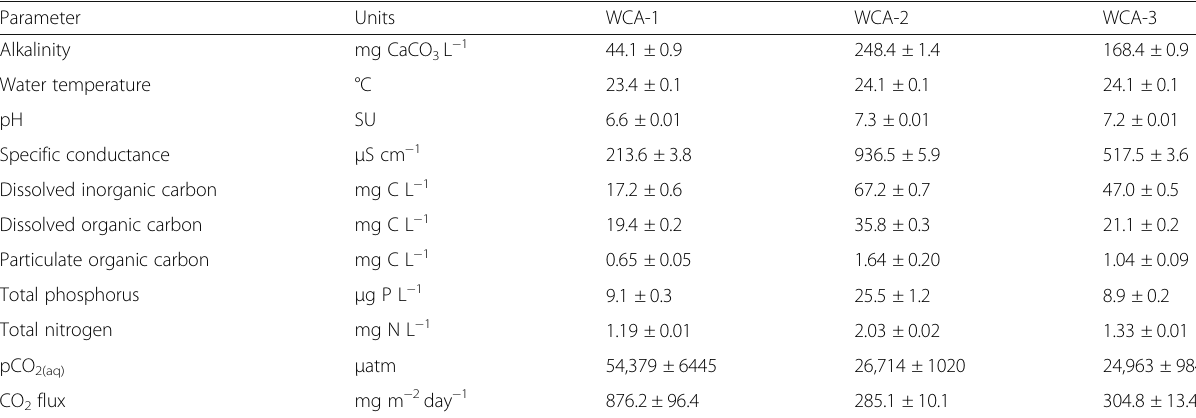
Table 3 Mean ± standard error surface water parameters observed during this study within each portion of the